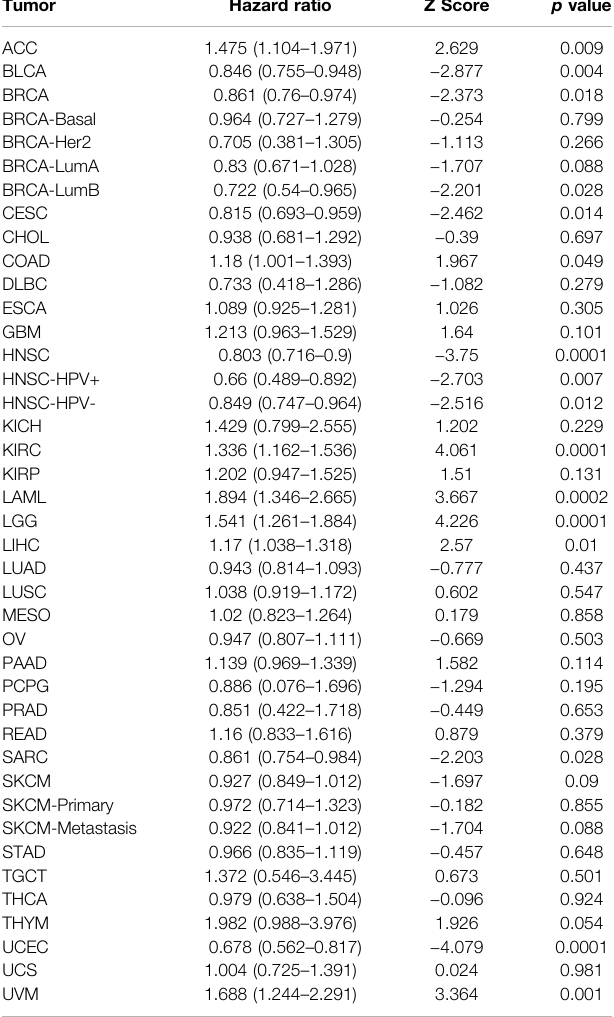
TABLE 1 | Cox regression analysis of BATF in cancers.